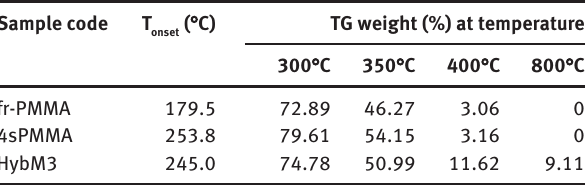
Table 3: Thermal characteristic of fr-PMMA, 4sPMMA and hybrid HybM3 samples under nitrogen at heating rate of 10 ° C min −1